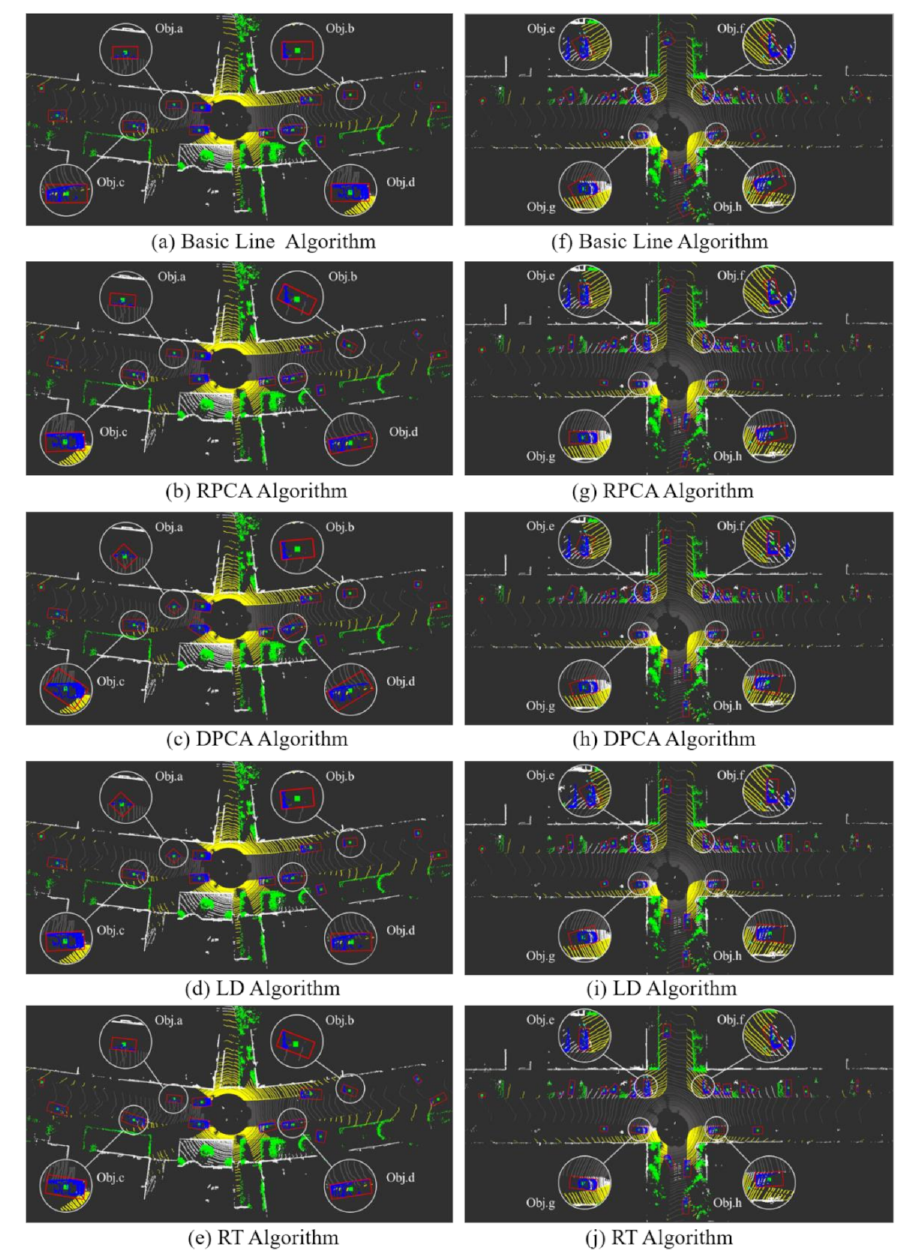
Figure 13. Comparison of the results of our five pose estimation algorithms. The blue point represents the obstacle vehicle point cloud, and the red box represents the bounding box of the obstacle’s pose estimation. The experimental conditions of ( a – e ) were small curvature roads, and the experimental conditions of ( f – j ) were